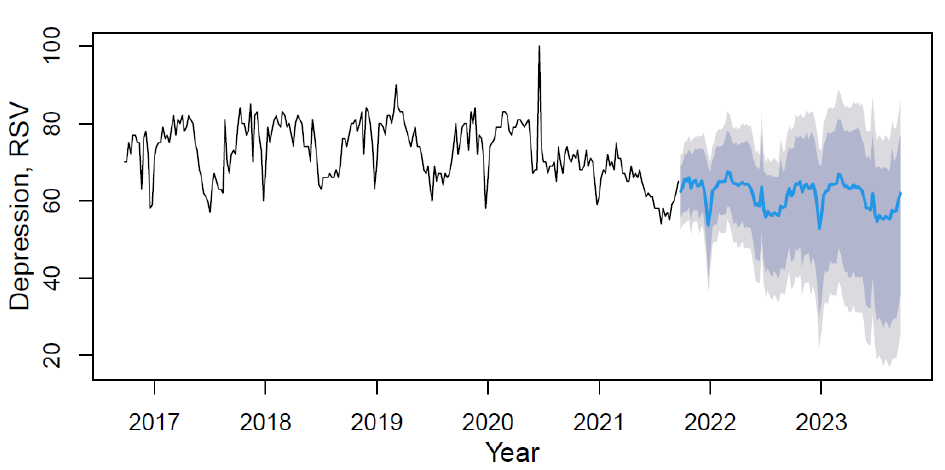
Table 3. I nsomnia’s hybrid model accuracy measures. ME